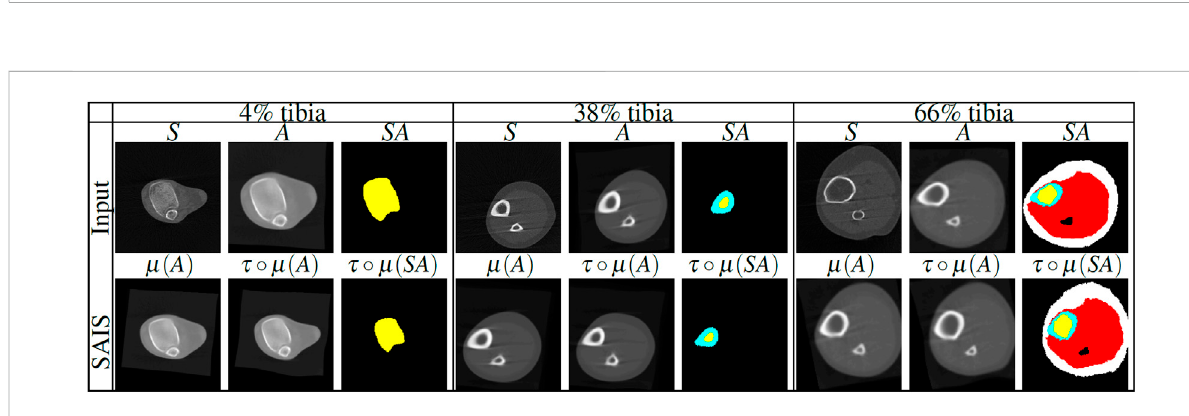
FIGURE 2 Illustration of single atlas based image segmentation (SAIS) stages of lower leg scans at 4%, 38% and 66% tibia. First row: subject ( S ), statistical atlas ( A ) and segmented atlas label map ( SA ) for each tibial length that are used as inputs for segmentation. Second row: linear registration,